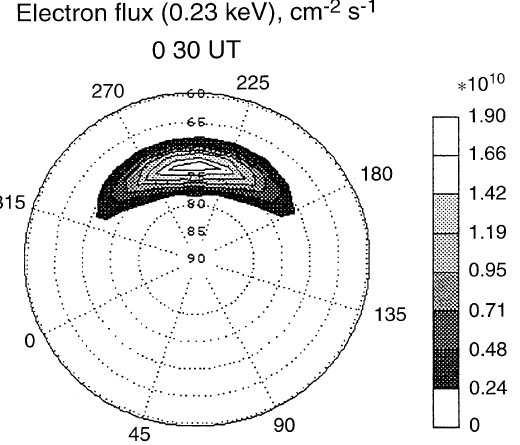
Fig. 3. Northern-hemisphere geomagnetic polar plot (60 °— 90 ° ) of the input precipitation flux of 0.23-keV electrons in case of the moving cusp at 0030